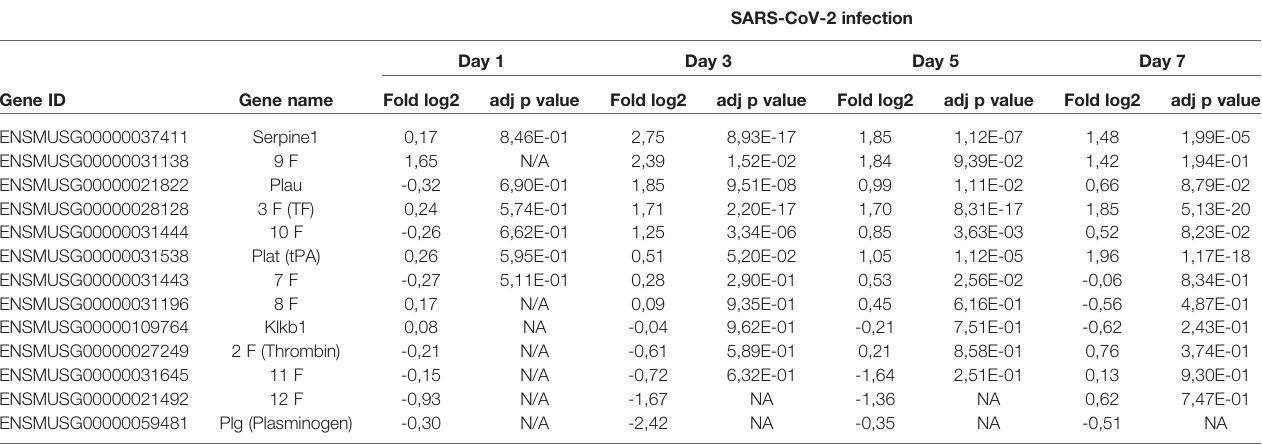
NA, Not Applicable.